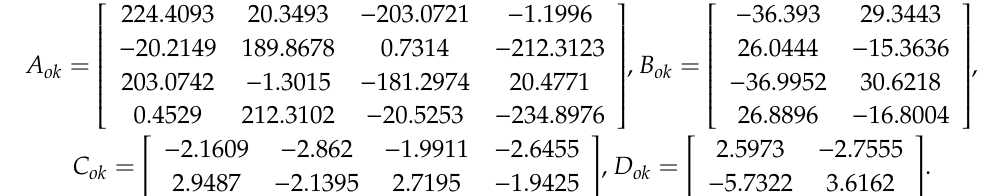
Figure 2. ( a ) Input disturbance d s 1 ( t ) (without state-dependent disturbance); ( b ) output d 1 so